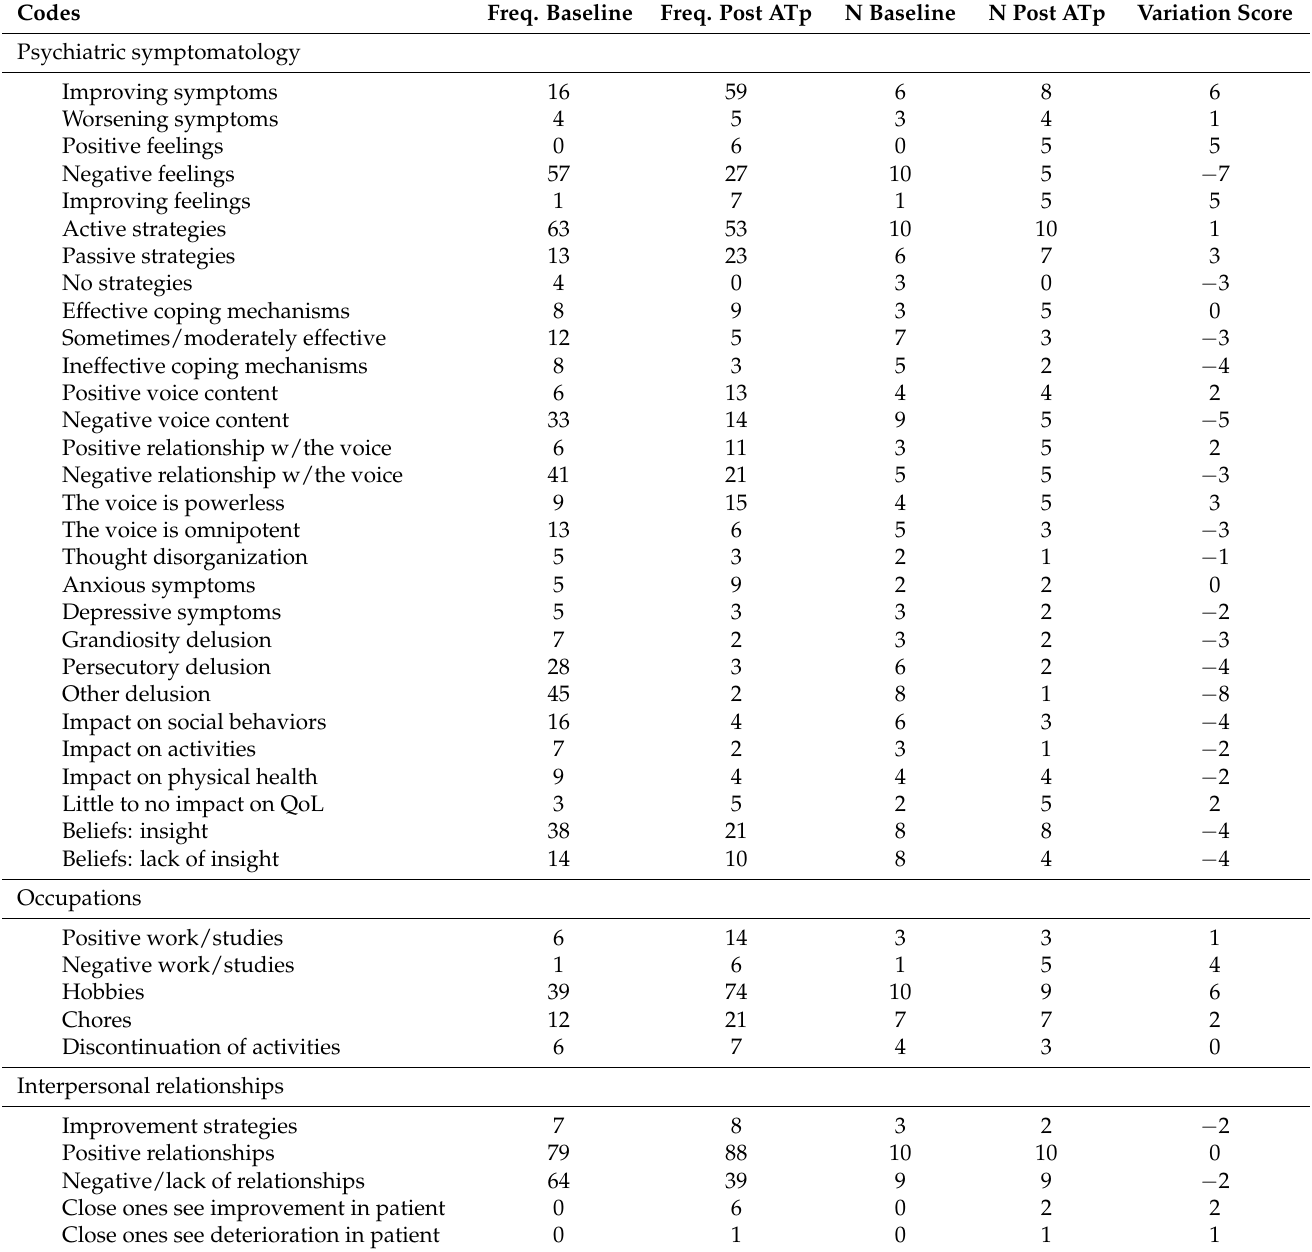
Table 4. Qualitative changes in quality of life following Avatar Therapy for psychosis. N =